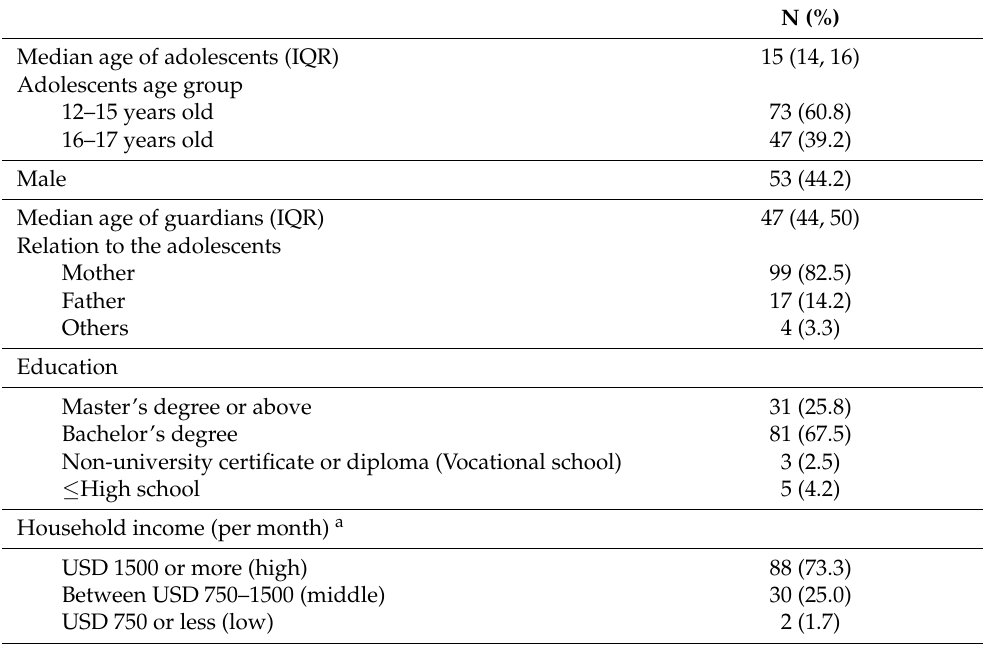
Table 1. Baseline characteristics of study